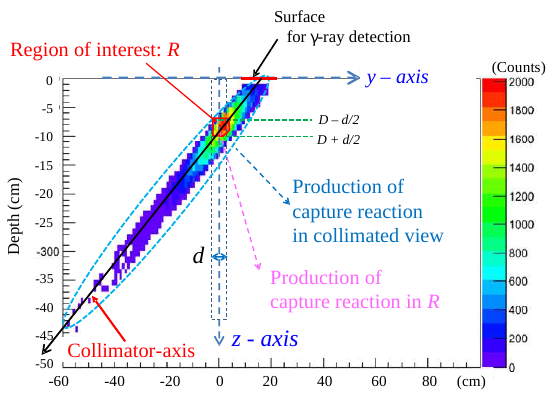
Figure 6 : Contour polt of 35 Cl production under simulation